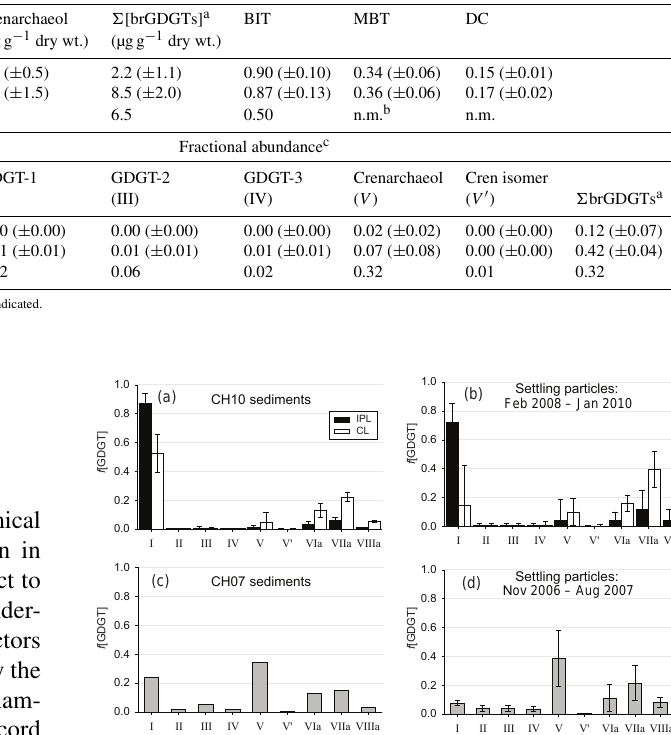
Figure 5. IPL and CL GDGT distributions from surface sedi- ments (a) CH10 from Buckles et al. (2014) with (b) corresponding weighted average IPL and CL GDGT distributions from summed fluxes of settling particles between 30 January 2008 and 30 January 2010, also from Buckles et al. (2014). (c) CL GDGT distributions from surface sediment CH07 from Sinninghe Damsté et al. (2009) and (d) corresponding weighted average CL GDGT distributions from summed fluxes of settling particles between 18 November 2006 and 24 August